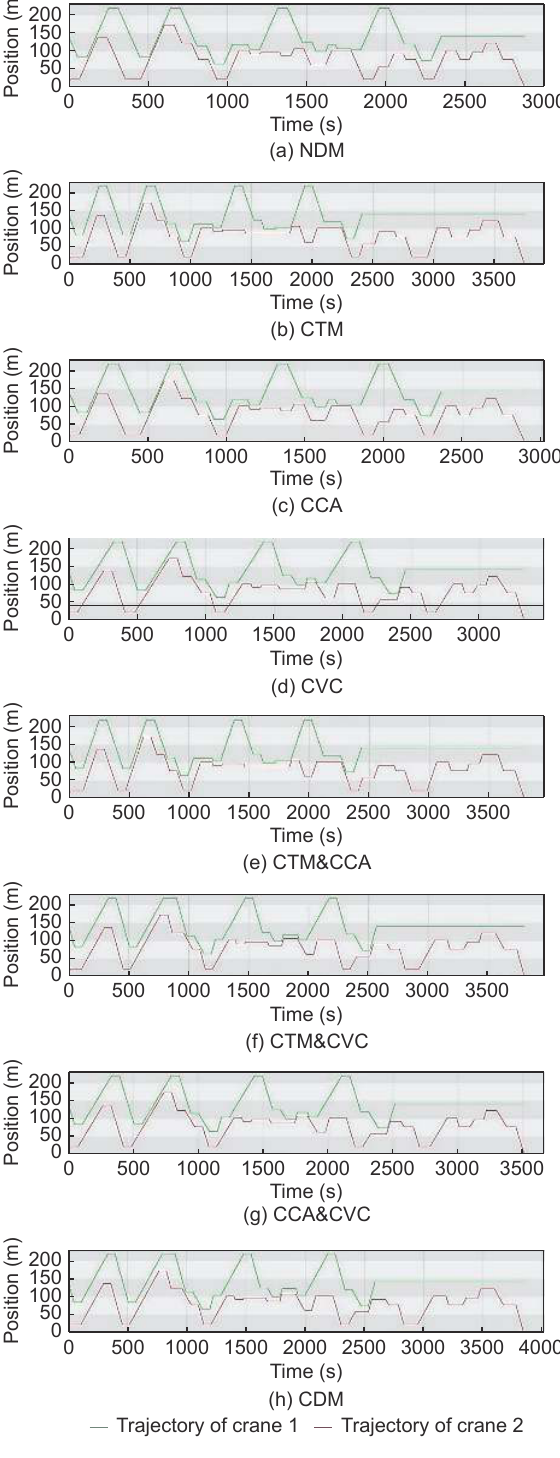
Fig. 13 Trajectories computed by the eight different detail